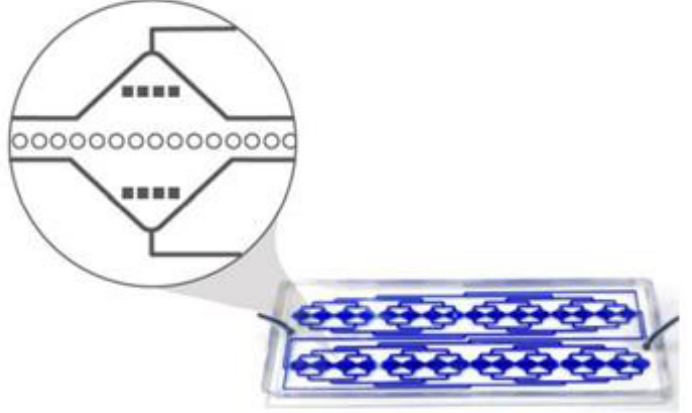
Figure 10. The RUBYchip™ is designed to capture CTCs based on physical properties such as size and cellular deformability. Filtering areas are composed by interspaced micropillars, distanced from each other in 5 µm.